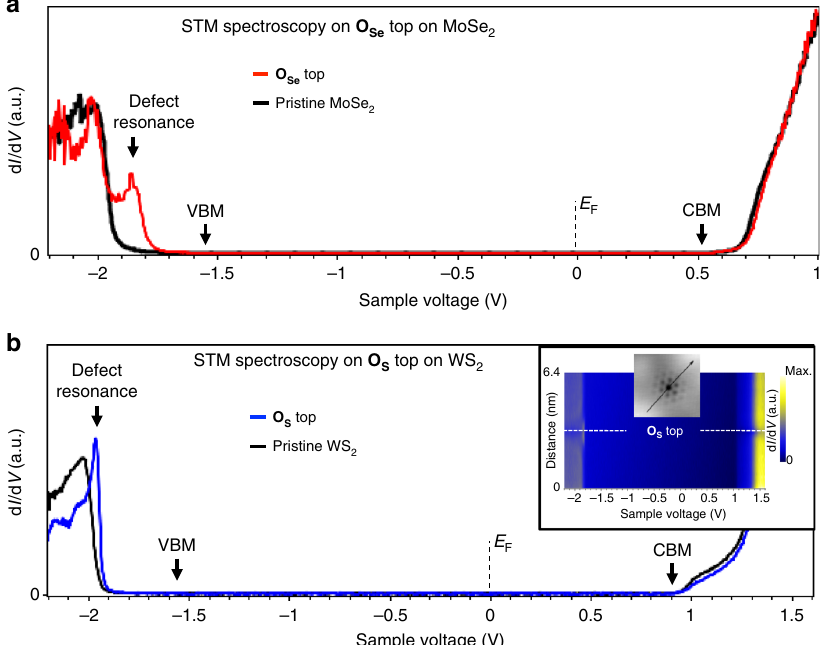
Fig. 2 Scanning tunnelling spectroscopy of substitutional oxygen in chalcogen site on 2D-MoSe 2 and 2D-WS 2 . a Representative STM d I /d V spectra acquired on the left defect in Fig. 1 — substitutional oxygen at a Se site, O Se , in 2D-MoSe 2 (red line) do not show deep in-gap states and a badgap equivalent to that measured on pristine sites (black line). Valence band maximum (VBM) and conduction band minimum (CBM) are marked with arrows. An additional defect resonance about 300 mV bellow the VBM it is observed in the defect ’ s spectra. b STM d I /d V spectra acquired on an substitutional oxygen, O S , at a S site in 2D-WS 2 (blue line) also show an equivalent bandgap to that measured on pristine sites (black line), lack of deep in-gap states and a defect resonance deep inside the valence band. Inset: Spatially resolved d I /d V conductance scan across the O S defect depicted in the inset reveals spatially distribution of the defects feature over 2 nm from the center of the O S (dotted-white line). Sample voltage of 0 V represents the Fermi level ( E F